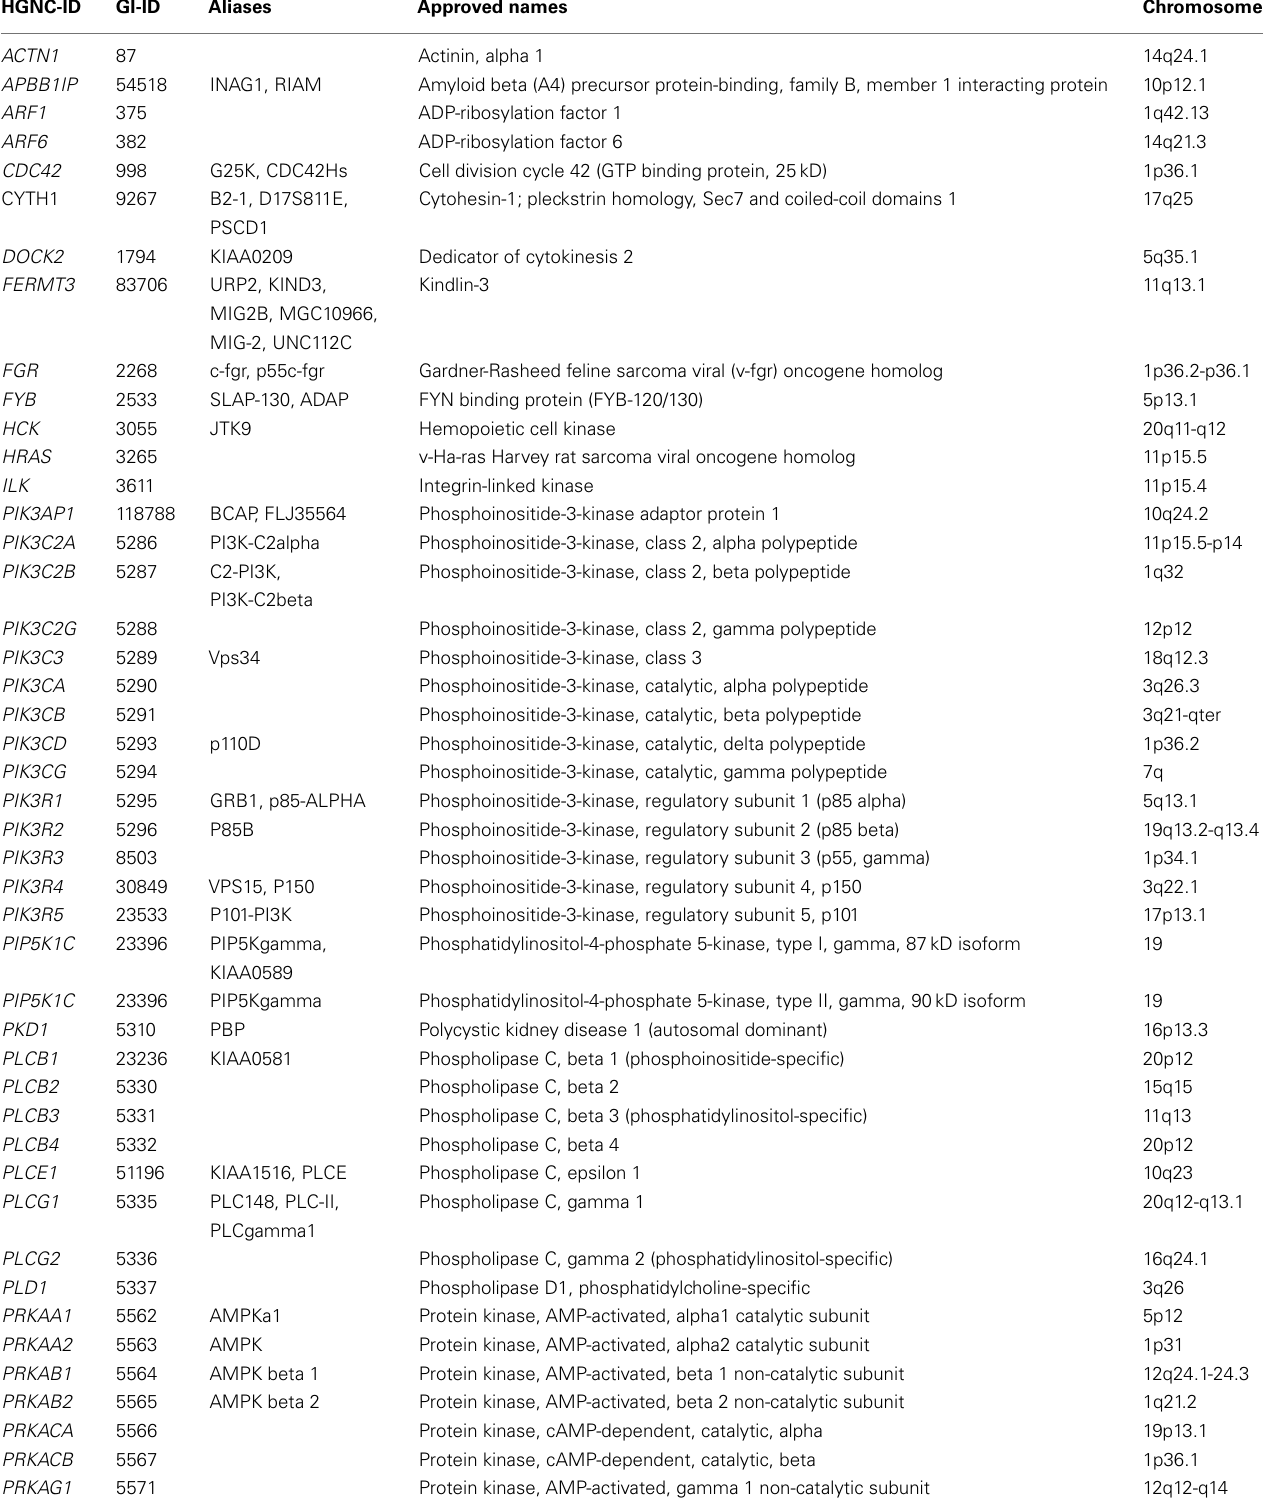
Table 1 |The signaling molecules involved in the regulation of integrin-dependent adhesion in leukocytes.